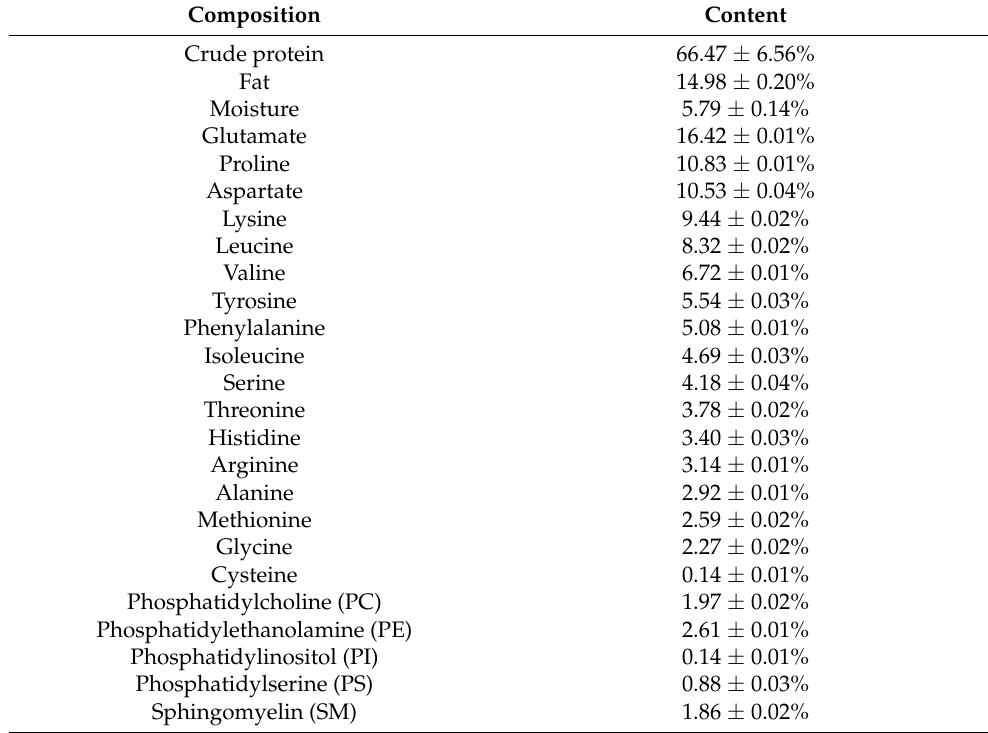
Table 1. Basic composition